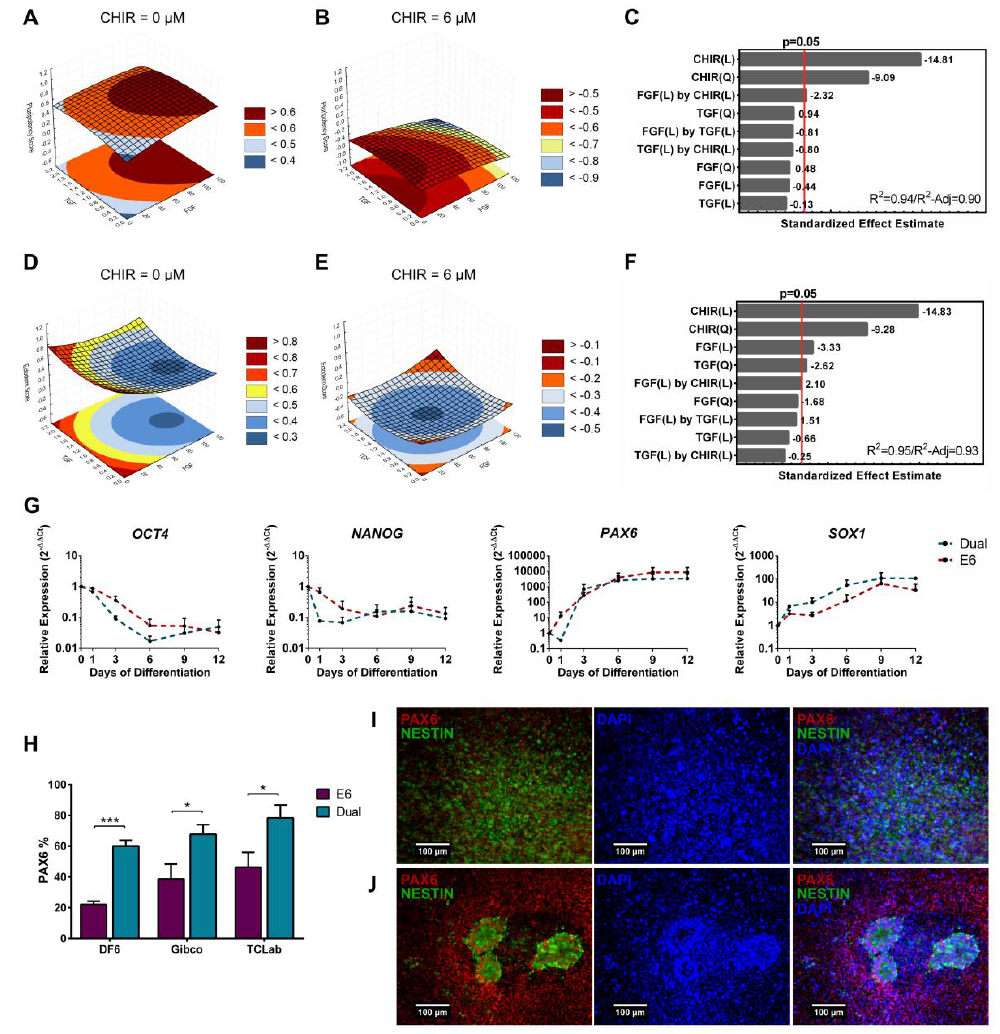
Figure 4. Quadratic models for the pluripotency and ectoderm scores highlighted a dominant negative contribution of Wnt signaling. ( A , B ) Representative curves of TGF β and FGF2 contributions to pluripotency model with CHIR set at zero ( A ) and at 6 µ M ( B ). Without CHIR, FGF2 high concentrations resulted in higher scores in the model, while with CHIR set at 6 µ M, both TGF β and FGF2 presence decreases pluripotency score. ( C ) CHIR linear and quadratic terms are the ones that contributed the most to the model, decreasing pluripotency scores. A statistically significant negative synergy can be seen between CHIR and FGF2. Model showed a good fit with a R 2 of 0.94 and a R 2 -Adjusted of 0.90. ( D , E ) Representative curves of TGF β and FGF2 contributions to ectoderm model with CHIR set to zero ( D ) and to 6 µ M ( E ). Without CHIR, the model output higher ectoderm scores, concordant with the significant negative effect. ( F ) Besides CHIR linear and quadratic negative effects, FGF2 linear, TGF β quadratic and an interaction between CHIR and FGF2 contributed significantly to the model. FGF2 positively contributed when conjugated with CHIR, while negatively contributed for ectoderm score without CHIR. TGF β negative quadratic term contribution can be clearly observed when FGF2 is zero ( D ) with higher ectoderm scores at full or no activation. Model showed a good fit to the data set with a R 2 of 0.95 and a R 2 -Adjusted of 0.93. ( G ) Real-time PCR comparison of E6 and dual SMAD inhibition neuroectoderm differentiation revealed a delayed expression decrease of the pluripotency markers OCT4 and NANOG for the differentiation without factors (E6). Error bars, SEM, n = 3. ( H ) PAX6 positive cells quantification showed that dual SMAD differentiation originated 20% to 40% more PAX6 + cells for the three cell lines tested, when compared with E6 differentiation at day 12. Error bars, SEM, n = 7 DF6 and Gibco, and n = 5 TCLab. * p -value < 0.05, *** p -value < 0.001 (two-sided t -test). ( I , J ) At day 12, dual SMAD ( I ) differentiation did not result in neural rosette formation while cells differentiated using only E6 ( J ) consistently organized in neural rosettes throughout the culture. Scale bar: 100 µ m. See Figures S2 and S3, and Tables S2 and S3 for pluripotency and ectoderm full model